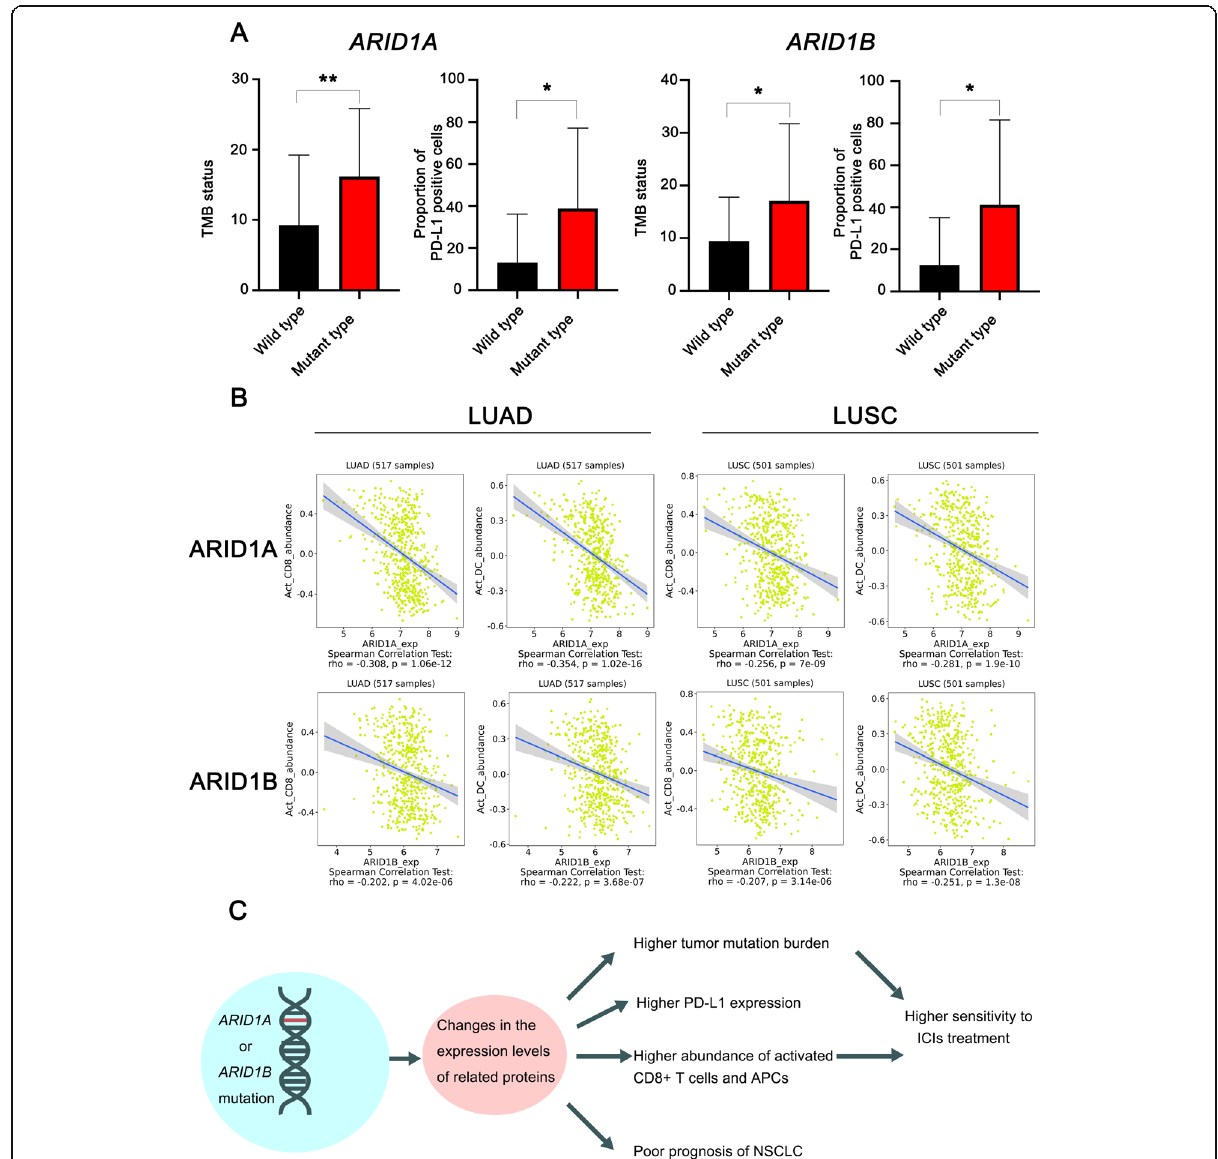
Fig. 4 ARID1A or ARID1B mutations are tightly associated with sensitivity to immune checkpoint inhibitors (ICIs). a . The comparison of tumor mutational burden (TMB) values and PD-L1 expression grouped by the genomic signatures of ARID1 subunits; b . The correlations between ARID1A or ARID1B expression and the abundances of activated CD8+ T cells and activated dendritic cells (DC) in lung adenocarcinoma (LUAD) and lung squamous cell carcinoma (LUSC); c . The underlying relationships between prognosis and ARID1A or ARID1B mutation deduced from this research. (**: P <0.01; *: P